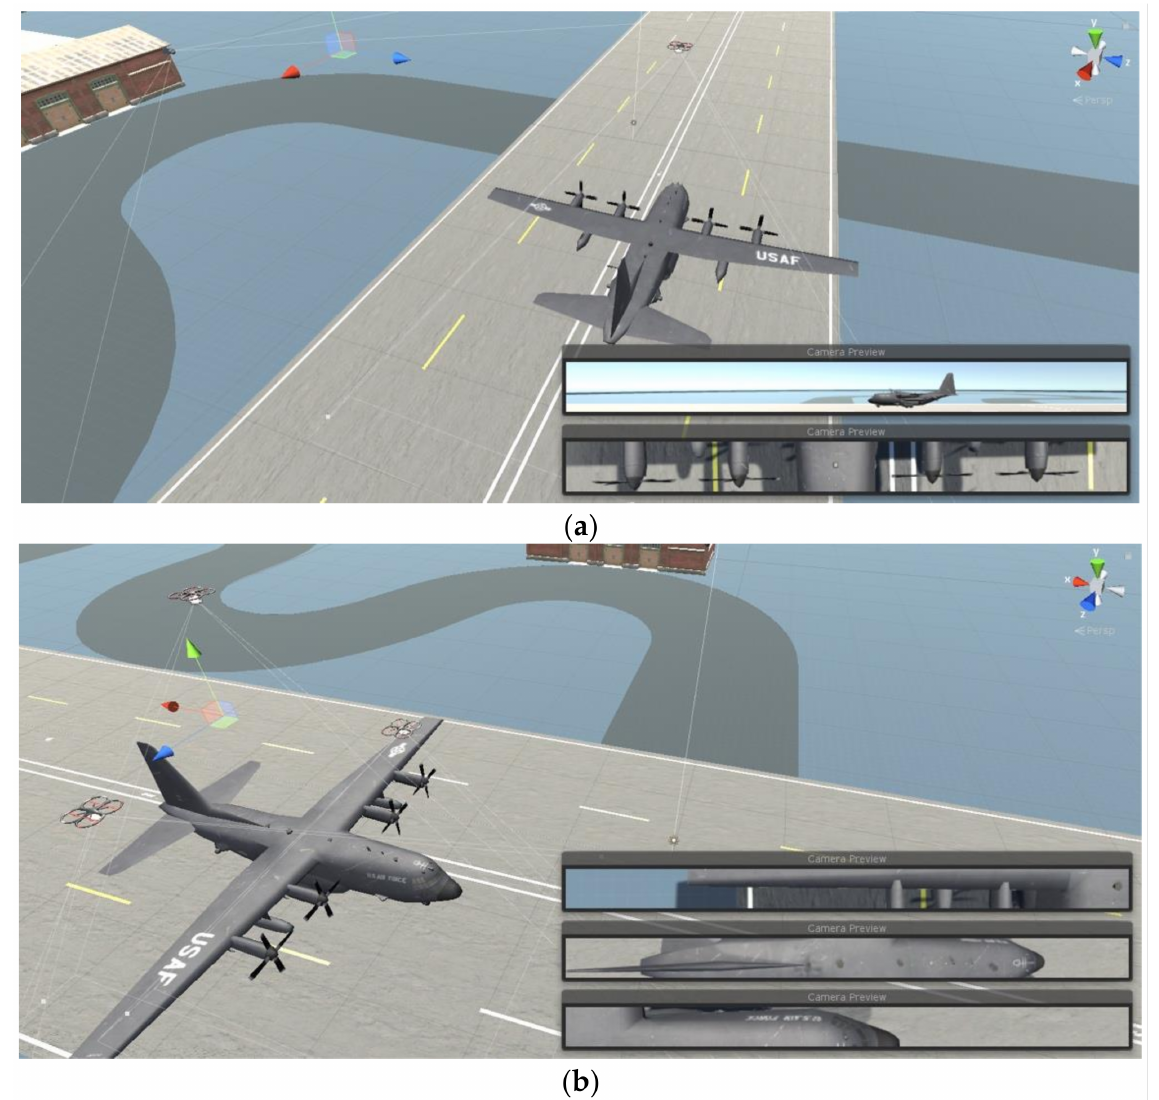
Figure 5. ( a ) Scenario with UAV and surveillance cameras, ( b ) scenario with multiple surveillance